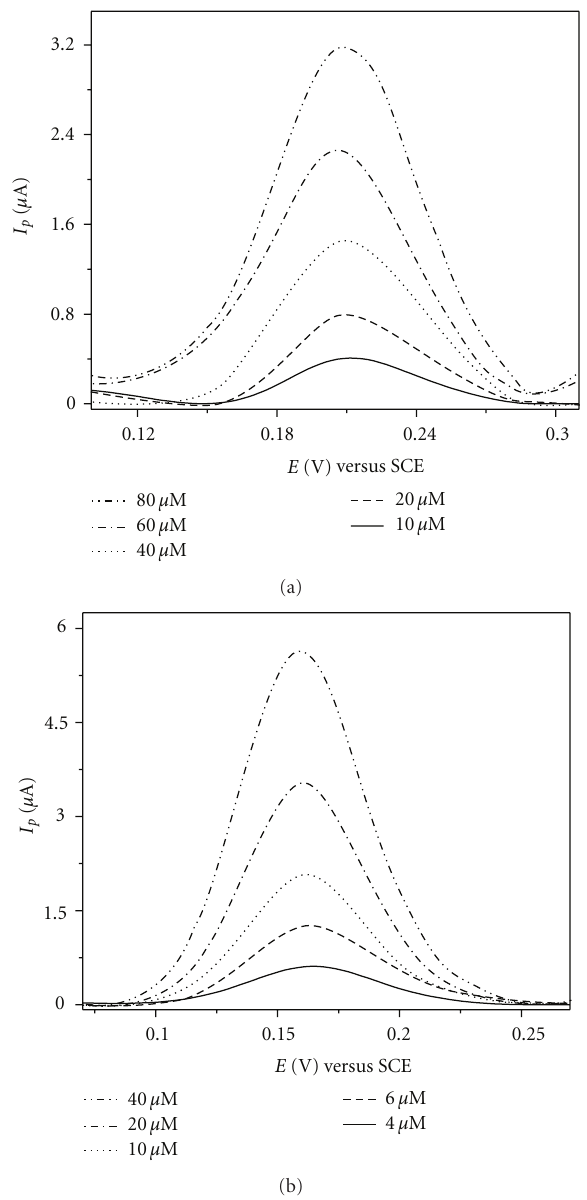
Figure 5: Baseline-subtracted di ff erential pulse voltammograms of (a) CD and (b) BS at di ff erent concentrations in 0.1 M PBS at pH 5.0, using a MWCNT/PNB-modified electrode.